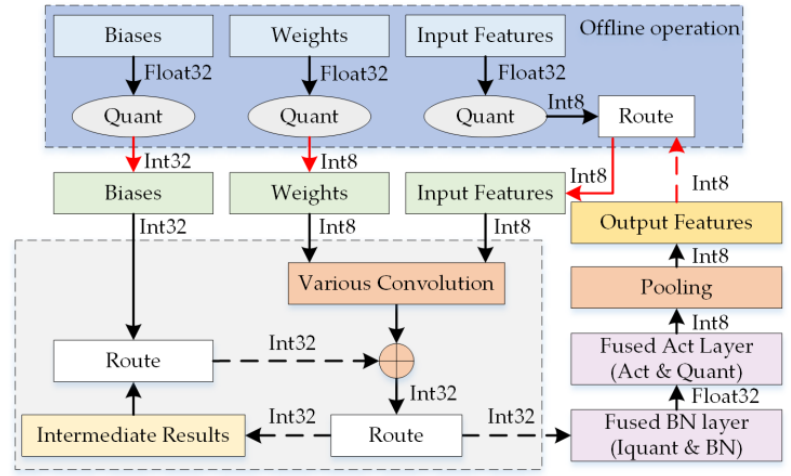
Figure 5. The forward inference calculation process after network quantization and layer fusion.